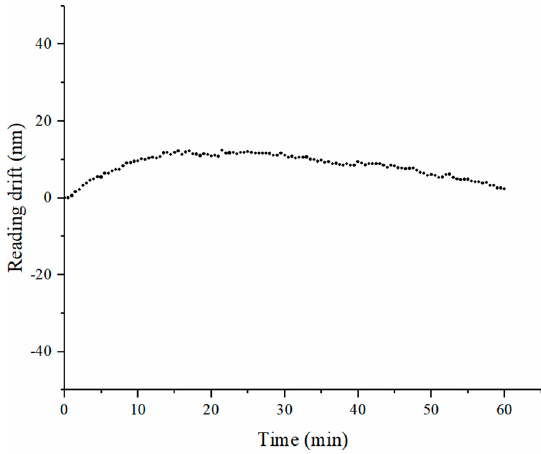
Figure 18. Reading drift of the film interferometer.